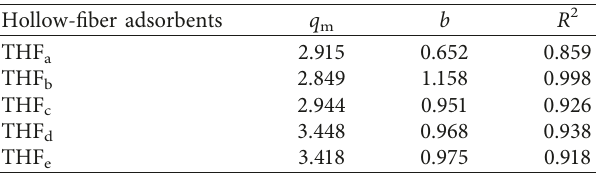
Table 4: Langmuir isotherm analysis of hollow-fiber adsorbents with different